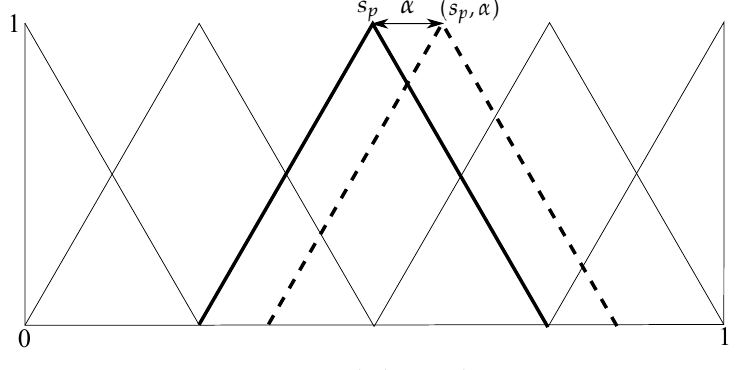
Figure 3. Symbolic